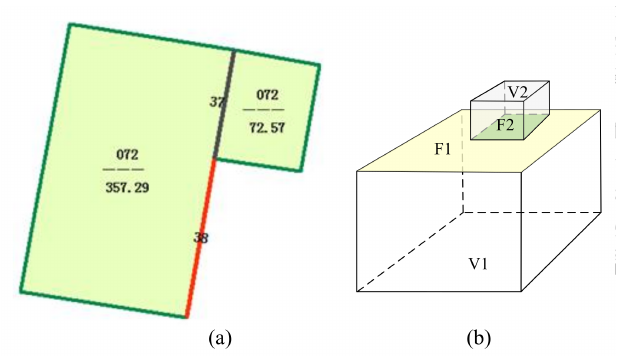
Figure 3. The boundary objects in cadastral management. ( a ) Example of divided boundary edges 37 and 38 between two 2-D parcels; ( b ) example of divided boundary polygon F1 and F2 between two 3-D